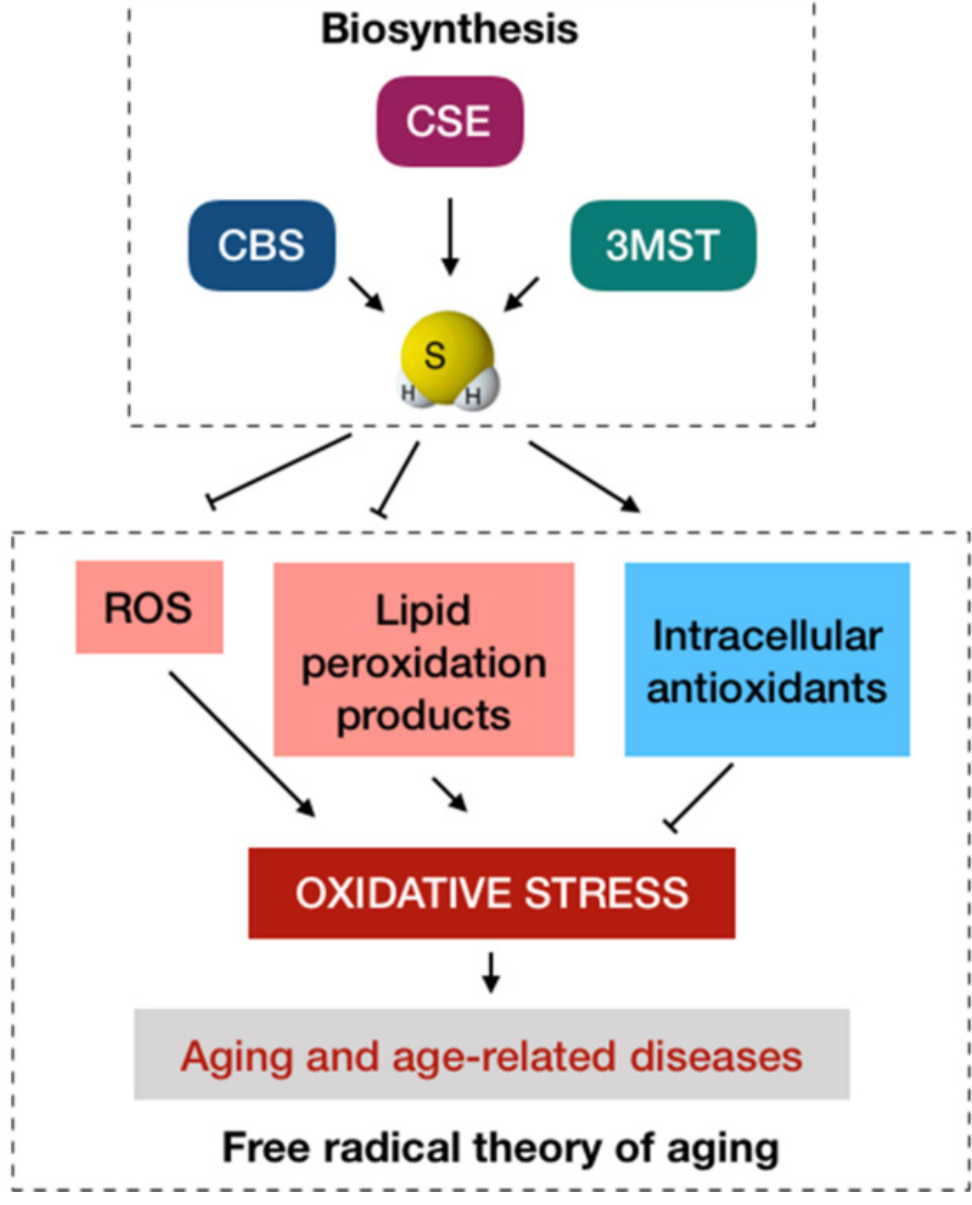
Figure 1. The conventional antioxidant paradigm of H 2 S in anti-aging. The biosynthesis of H 2 S in mammalian cells primarily involve cystathionine β -synthase (CBS), cystathionine γ -lyase (CSE), and 3-mercaptopyruvate sulfurtransferase (3MST). From the viewpoint of the free radical theory of aging, oxidative stress caused by the excessive production and accumulation of ROS is a major cause of aging that in turn has a progressive role in age-related diseases. H 2 S at physiological levels may function as an antioxidant to protect the cells and tissues from oxidative stress by scavenging ROS, reducing the aggregation of lipid peroxidation products, and increasing the generation of intracellular